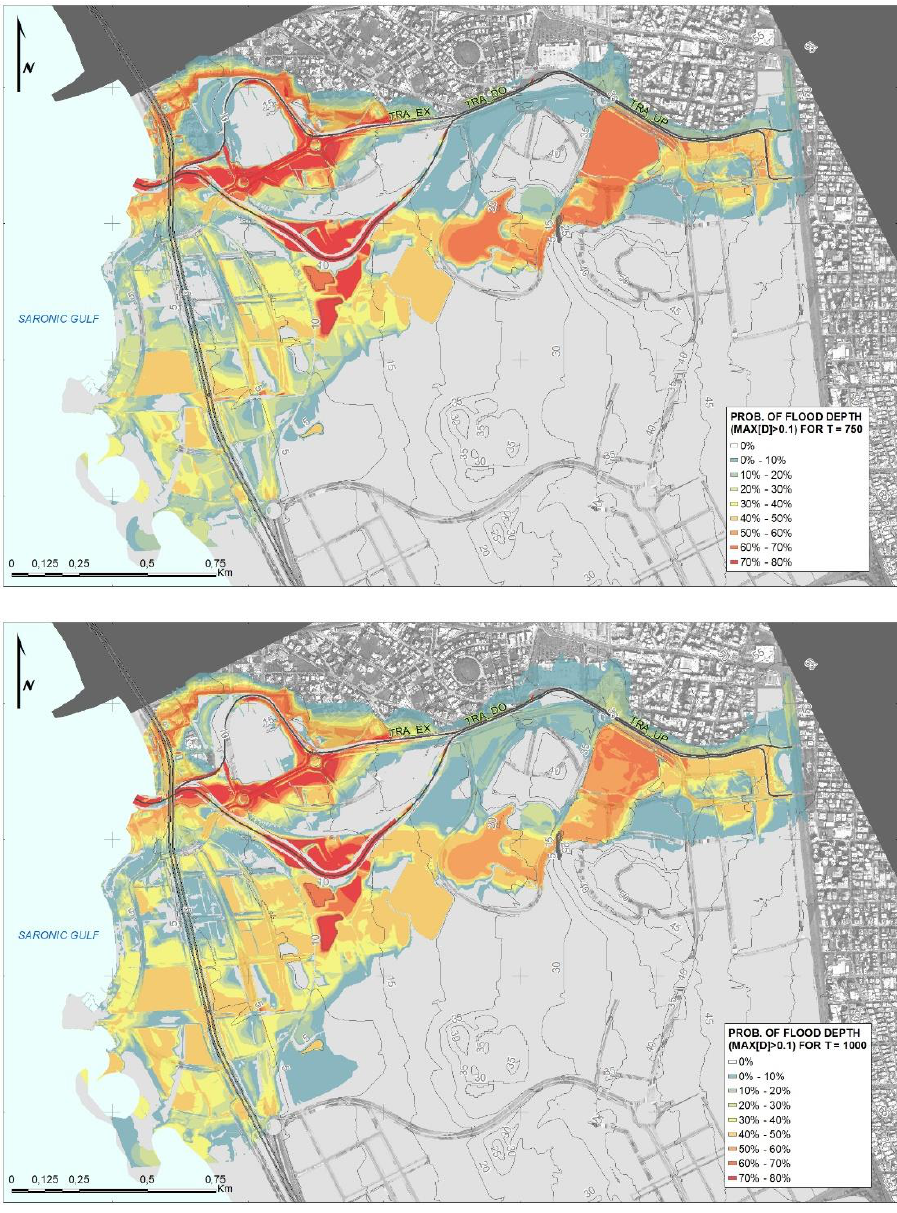
Figure A2. Probability of depth >0.1 m (curb height), for a rainfall event with 𝑇 = 750 years ( top ) vs. 1000 years ( bottom ).